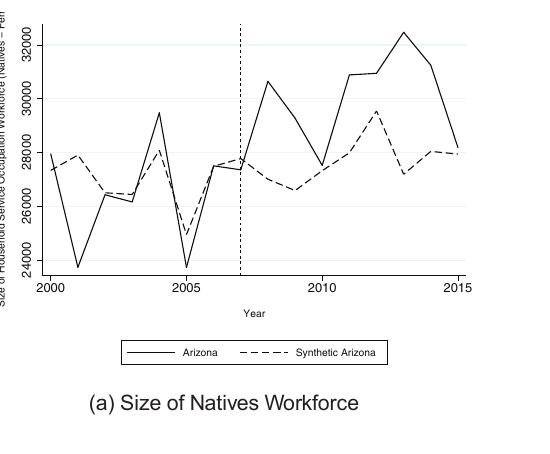
Figure A28 Size of native workforce (female) in household service occupations